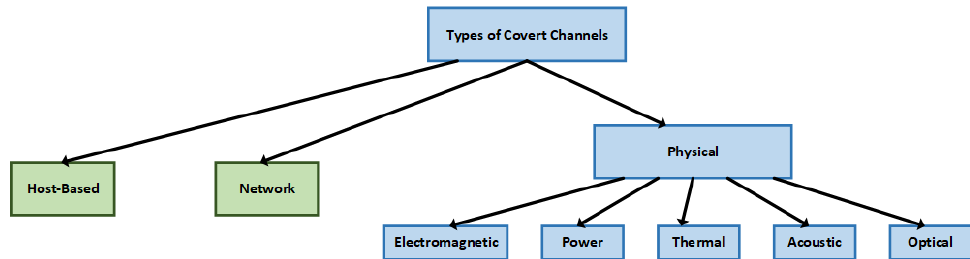
Figure 1. Classification of various covert